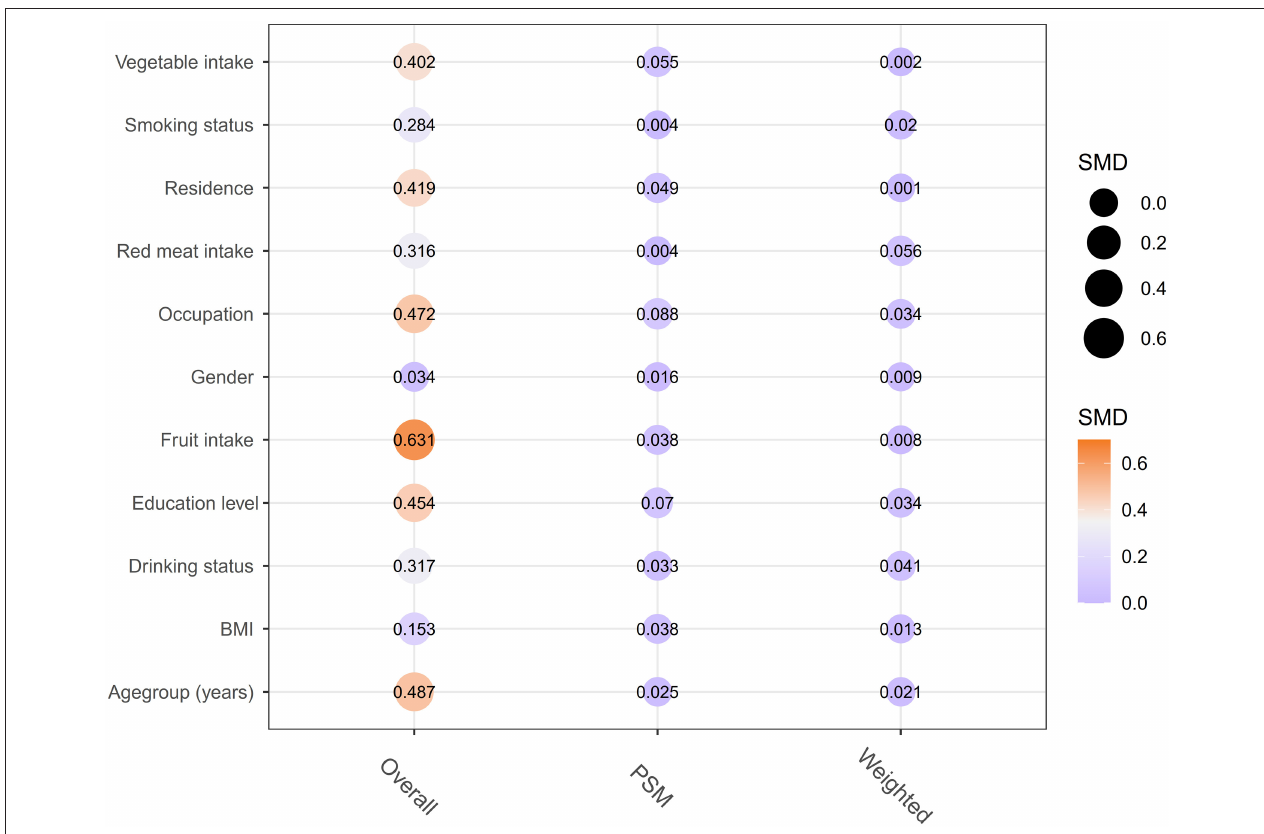
FIGURE 1 | Comparison of the distribution of matching factors between cases and controls before and after matching, Group differences were assessed using standardized mean differences (SMD), with an SMD value of 0.1 considered balanced.